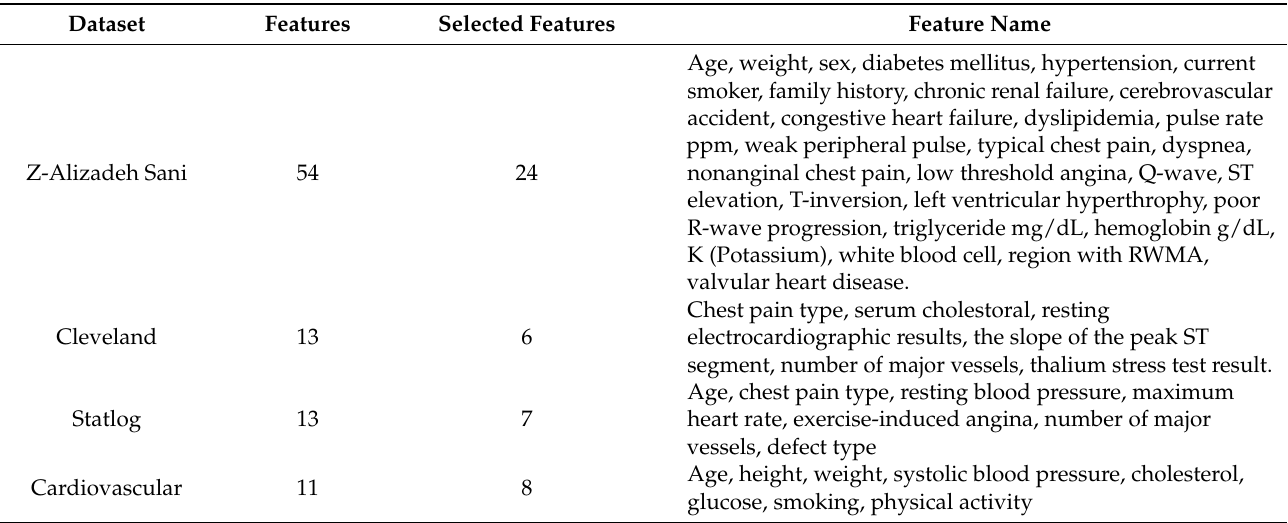
Table 2. Number of selected features for each heart disease dataset using the SVM classification.